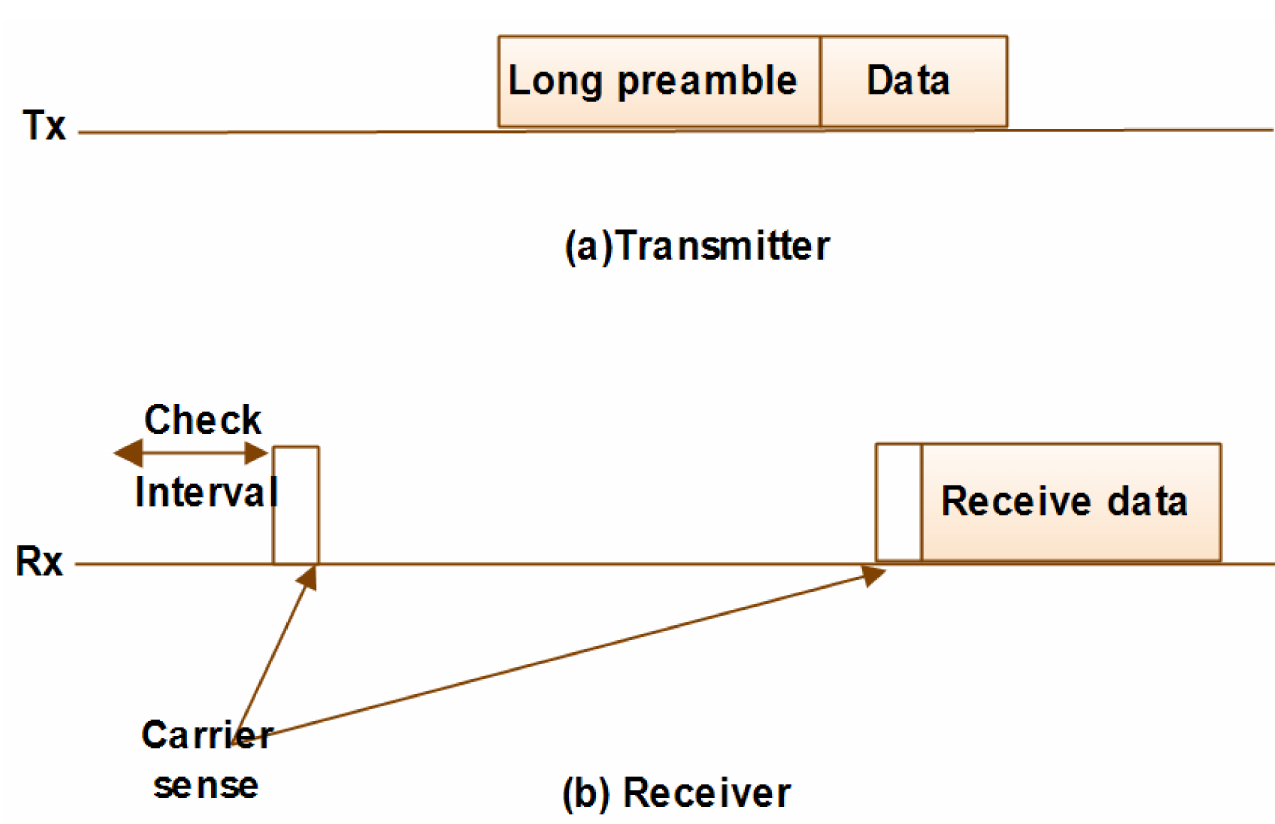
Figure 5. The B‑MAC